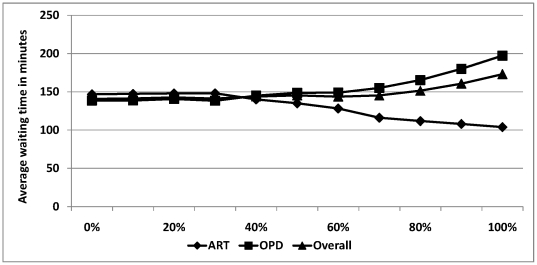
Average waiting time of ART patients, OPD patients and overall in the post-integration clinic as a function of the fraction of OPD patients who accept PITC.